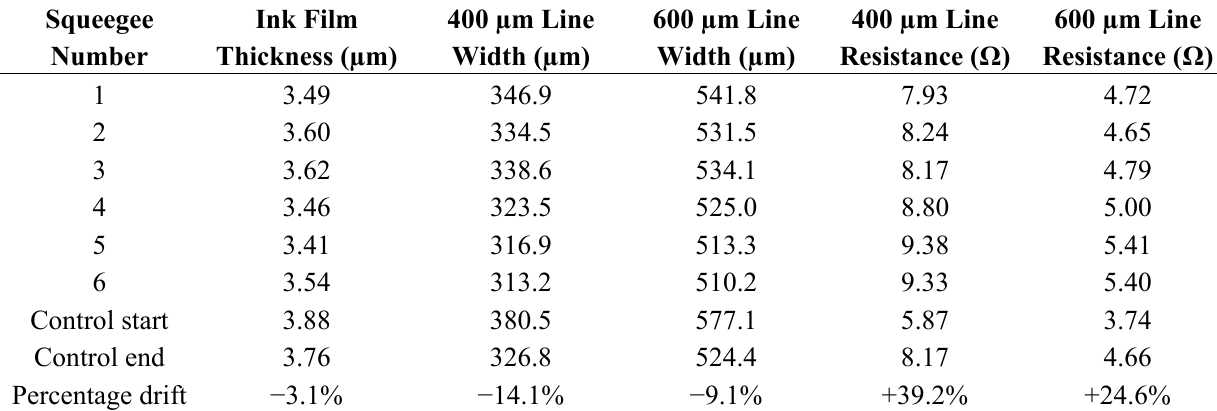
Table 6. Ink film thickness, line width and line resistance for unworn squeegees. Averaged over all